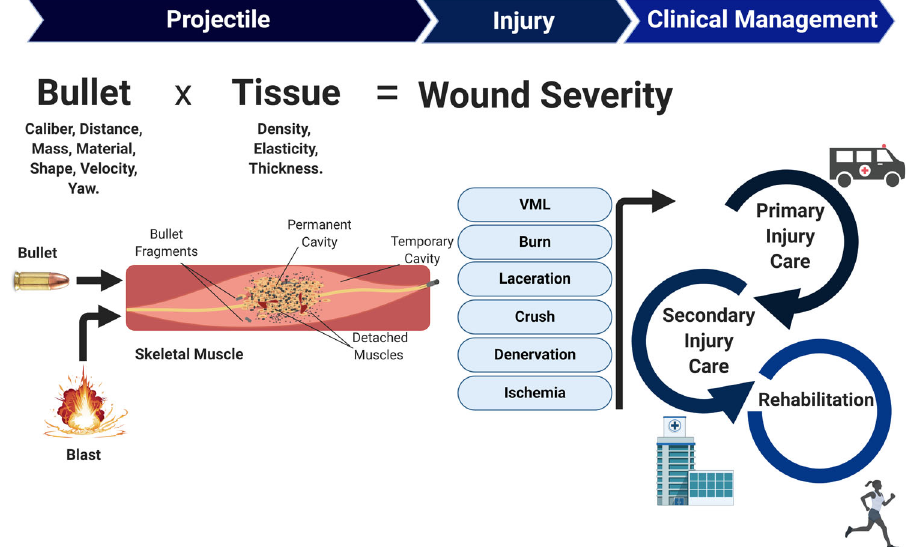
Fig. 1 Summary of the key considerations involved regarding fi rearm-related muscle trauma and its clinical management. The properties of the projectile (i.e., bullet or explosive blast fragments) and muscle tissue impacted interact to determine the severity of the wound, which is dependent upon permanent and temporary cavitation as well as bullet fragmentation. The type of injury induced may range from very severe (such as volumetric muscle loss; VML) to mild (such as a minor laceration). The speed of the clinical response and management play a hugely important role for determining patient outcomes and functional recovery, which includes primary and secondary treatment alongside long- term